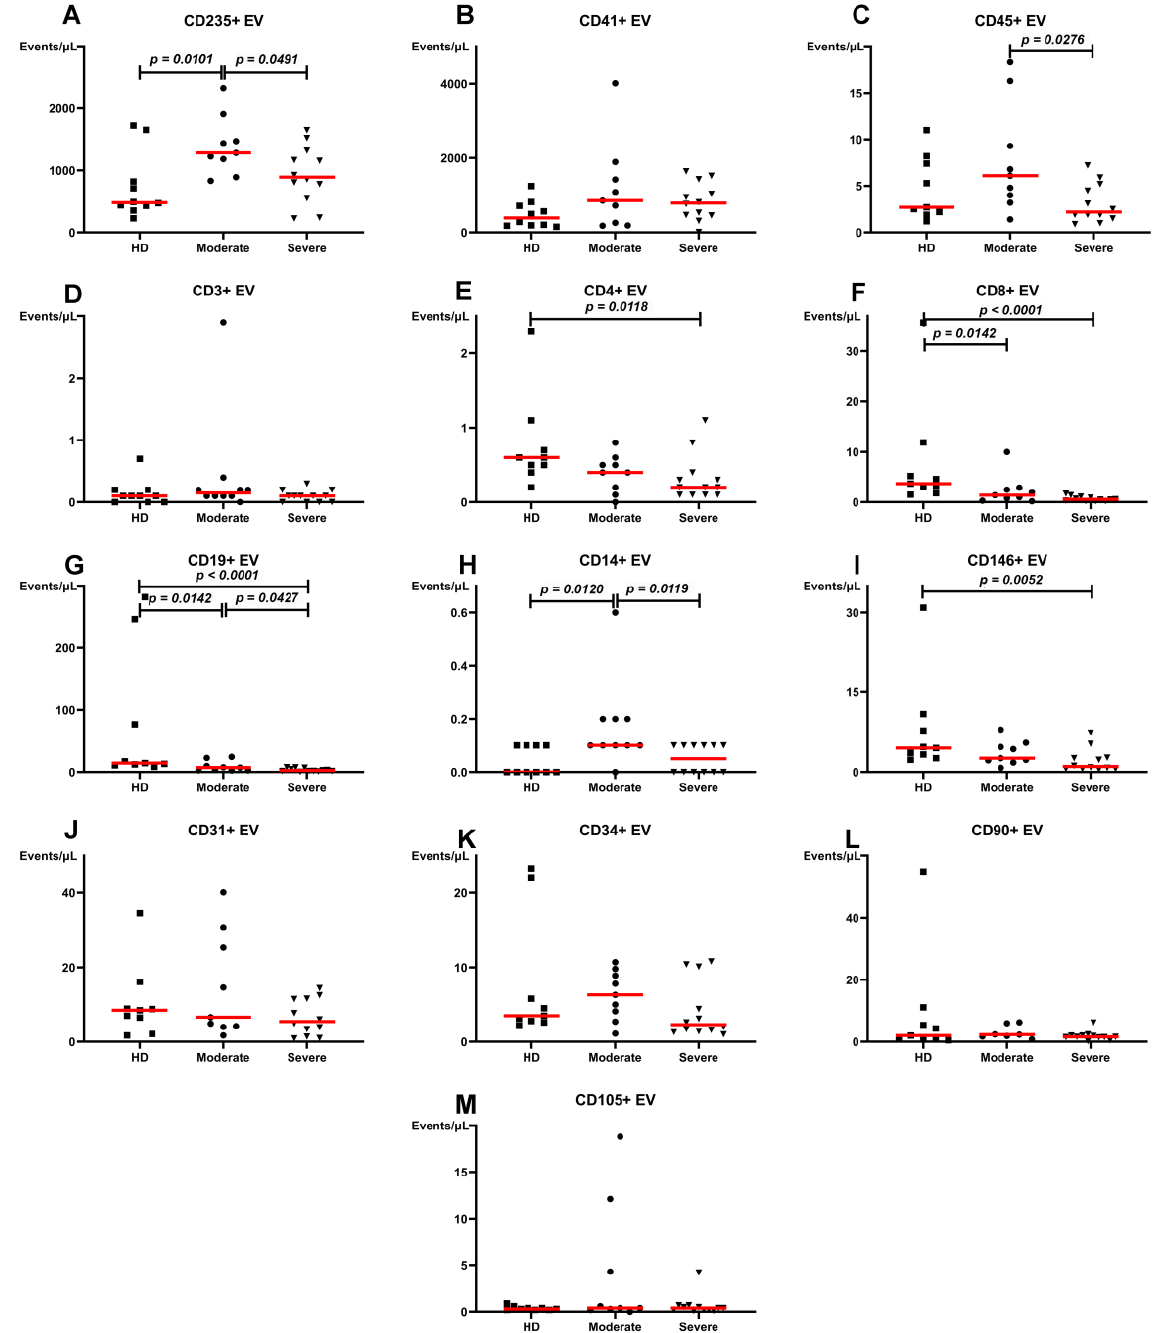
Figure 1. Concentration of plasma extracellular vesicles (EVs) in healthy donors, patients with moderate or severe COVID-19 at the beginning of in-patient department treatment, events/ µ L. ( A ). CD235a+ EV. ( B ). CD41+ EV. ( C ). CD45+ EV. ( D ). CD3+ EV. ( E ). CD4+ EV. ( F ). CD8+ EV. ( G ). CD19+ EV. ( H ). CD14+ EV. ( I ). CD146+ EV. ( J ). CD31+ EV. ( K ). CD34+ EV. ( L ). CD90+ EV. ( M ). CD105+ EV. Red lines represent median values.